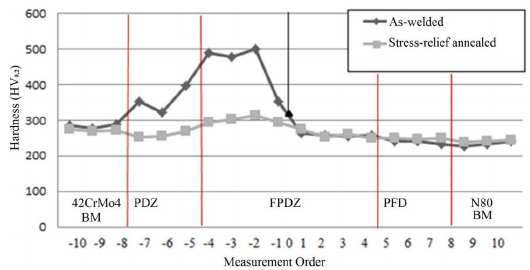
Figure 7. The hardness profile of friction welded N80-42CrMo4 couple.